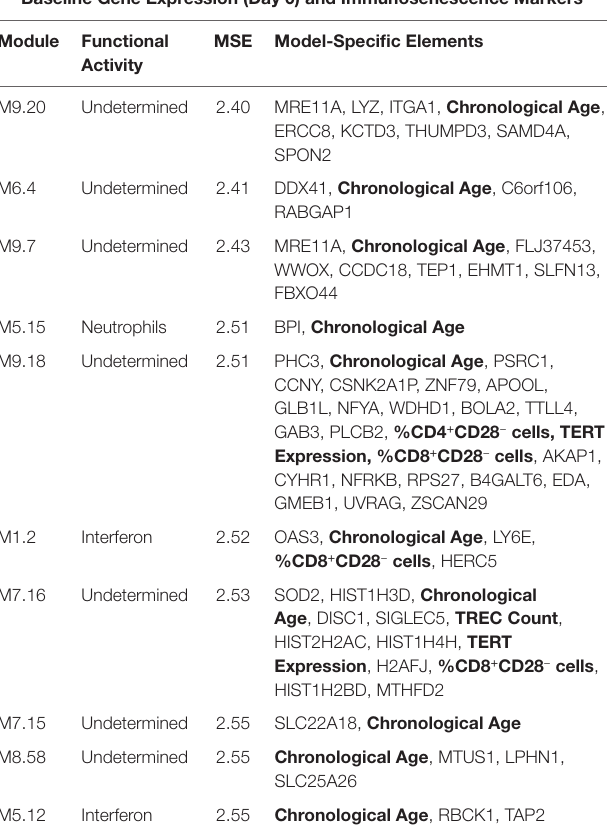
TaBle 2 | Penalized regression modeling of day 28 hai response.